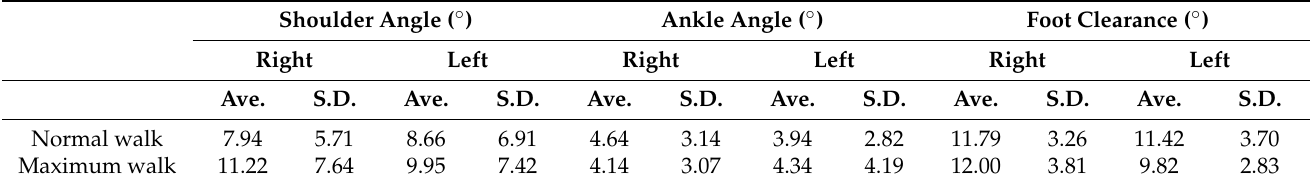
Table 5. Comparison of angle factor during the normal walking and fast walking of the elderly.